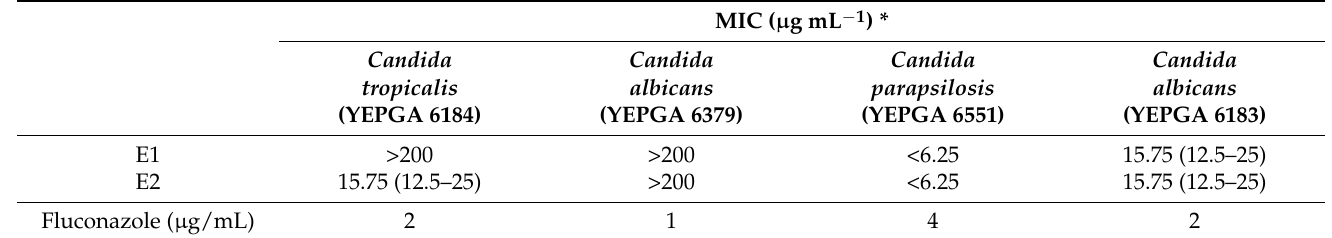
Table 4. Minimal inhibitory concentrations (MICs) of Cannabis sativa L. cv. strawberry extracts against yeast